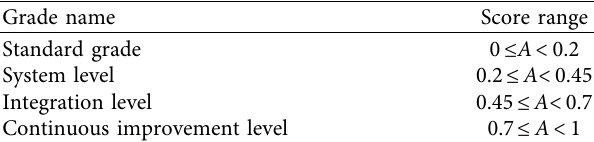
Figure 2: Conceptual characteristics of smart city construction. Table 1: Smart city construction project